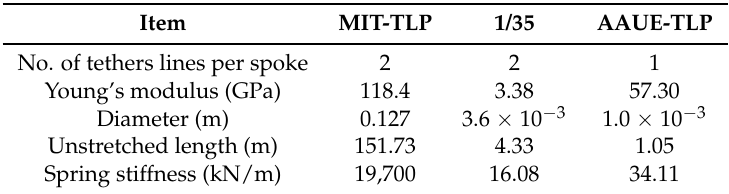
Table 5. Tethers